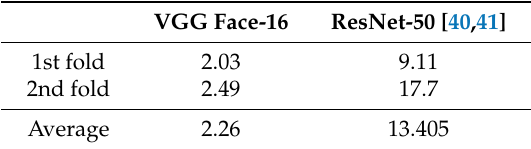
Table 5. Comparisons of EERs by VGG Face-16 and ResNet-50 for face recognition (unit: %).